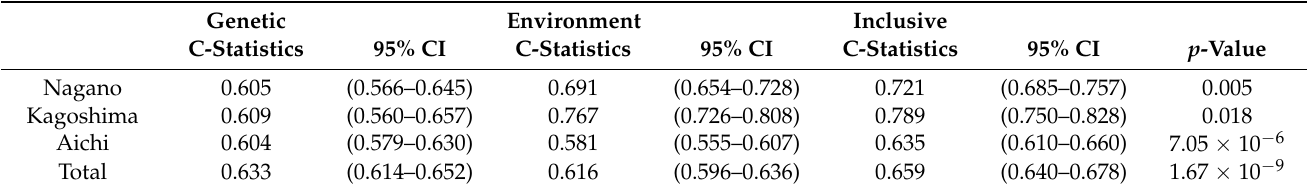
Table 3. C-statistics of genetic, environmental and inclusive risk